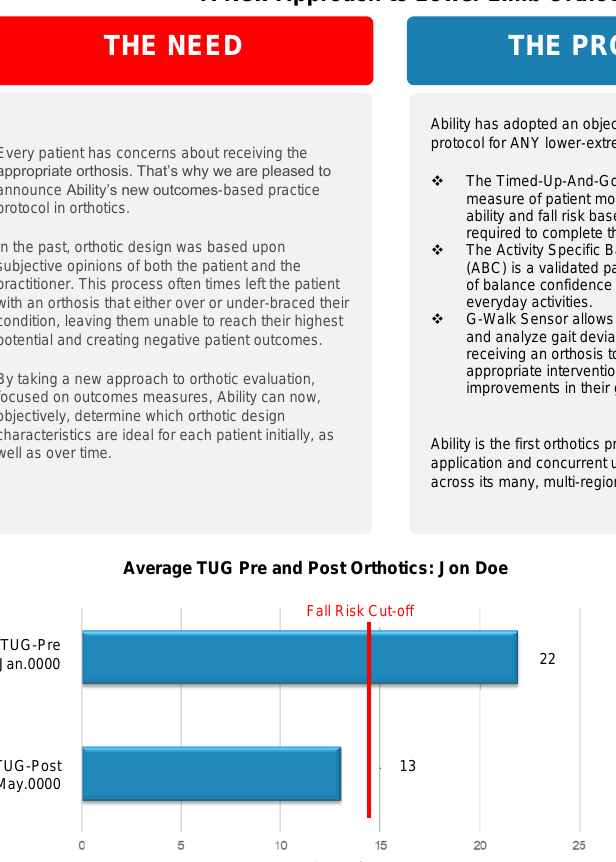
Figure 2: Ability’s Lower Limb Orthotics (LLO) outcome measure protocol with a sample Pre and Post Outcome Measure.